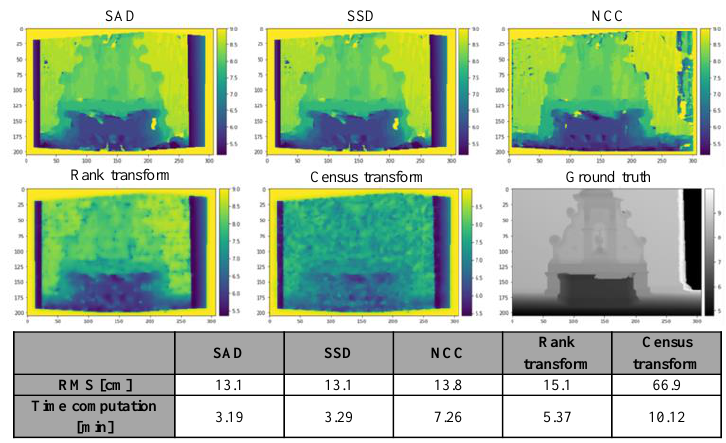
Figure 4. Impact study of photo-consistency measurements on depth maps